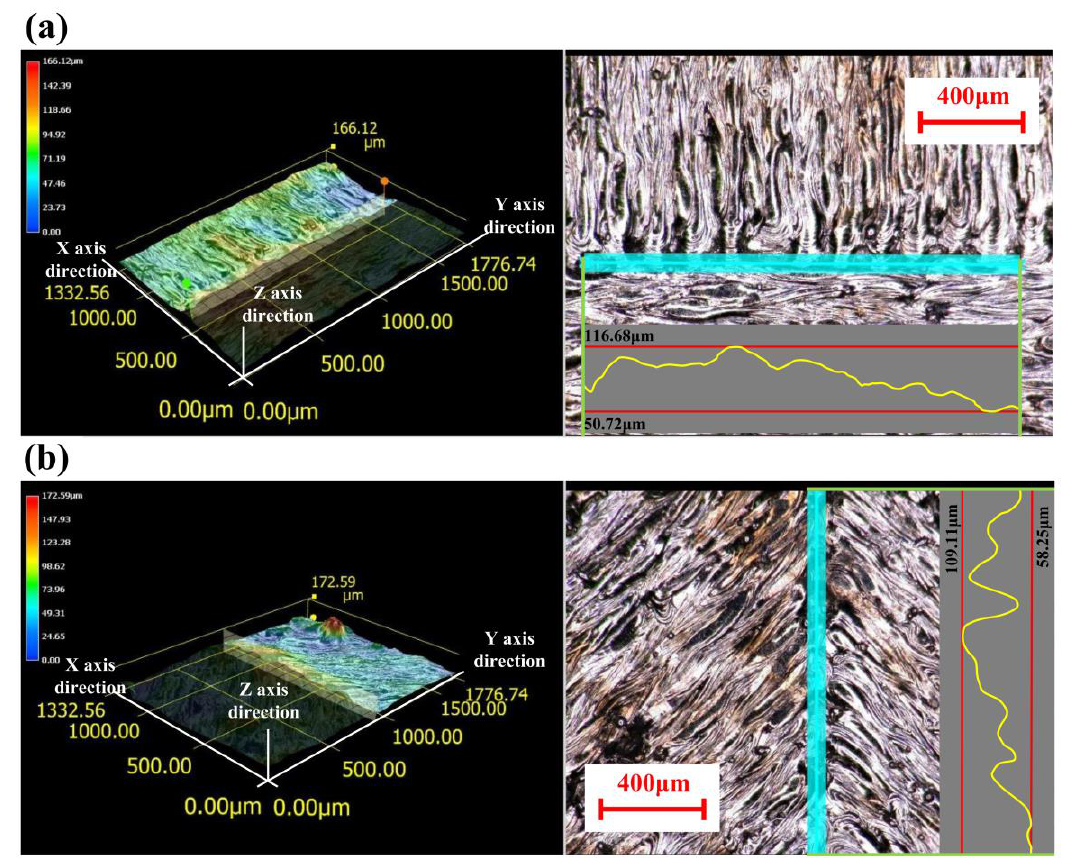
Figure 8. Surface measurement of overlap: ( a ) Overlap between two groups of scanning lines which was used in the normal partition strategy and the spiral divisional strategy; ( b ) Overlap between a single scanning line and one group of scanning lines, which was used in the oblique line and layer-staggered divisional strategy.